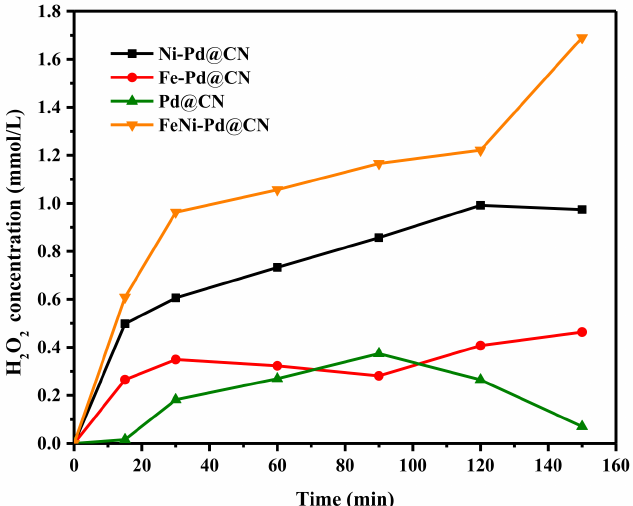
Figure 6. The H 2 O 2 production ability over as-prepared catalysts (Catalyst dosage: 2 g/L; FA: 46.6 mmol/L; air; 200